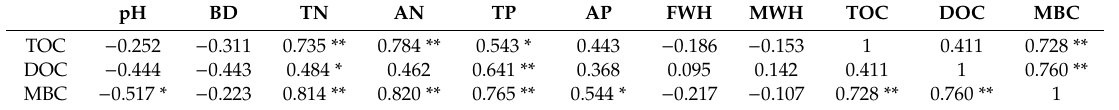
Table 6. Pearson’s correlation between TOC, DOC, MBC and soil properties. pH